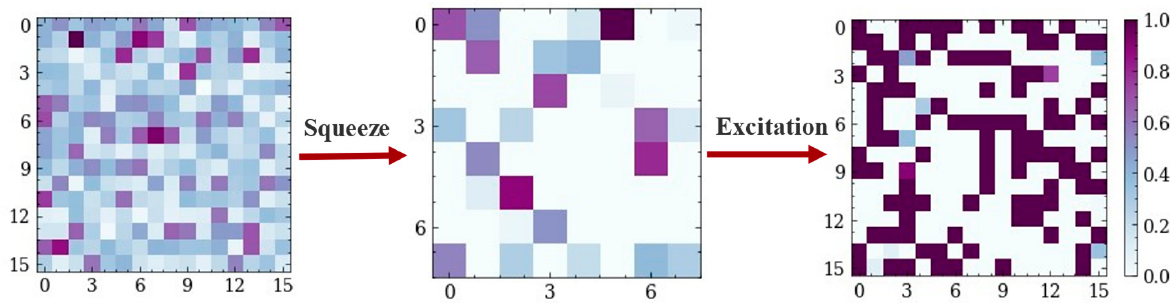
Figure 9. Visualization of the SE-Res block channel attention distribution. After the Squeeze-Excitation operation, the distribution of weights among different feature maps is more discrete. A large number of fault-independent feature maps are adaptively and dynamically eliminated, preserving the information dependencies between different channels. After the excitation operation, the relationship between channels has stronger sparsity and redundant information is effectively